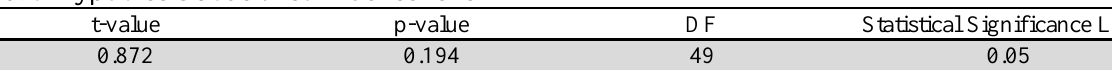
Fourth hypothesis at 95% confidence level t-value p-value DF Statistical Significance Level 0.872 0.194 49 0.05